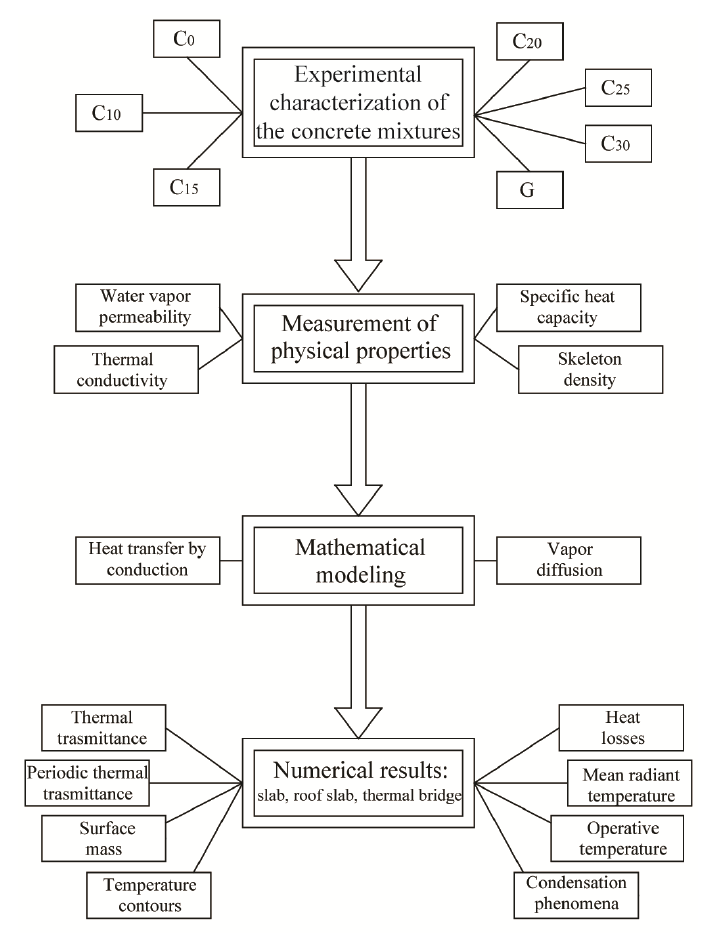
Figure 1. Flow-chart of the work carried out by the